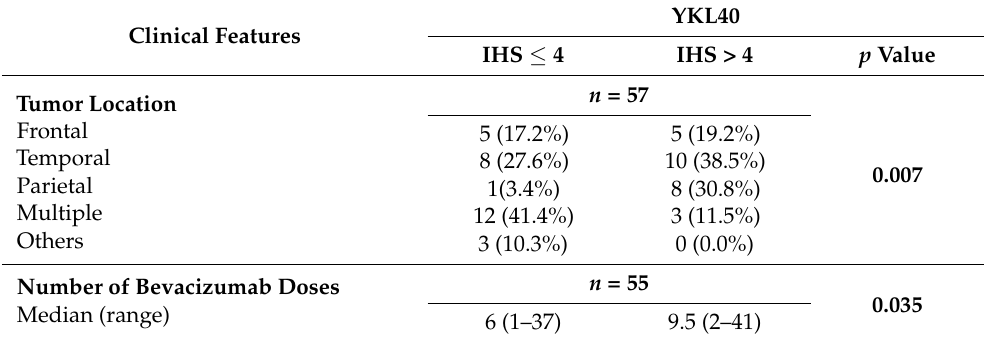
Table 6. Association of clinicopathological features of GB patients with the expression levels of